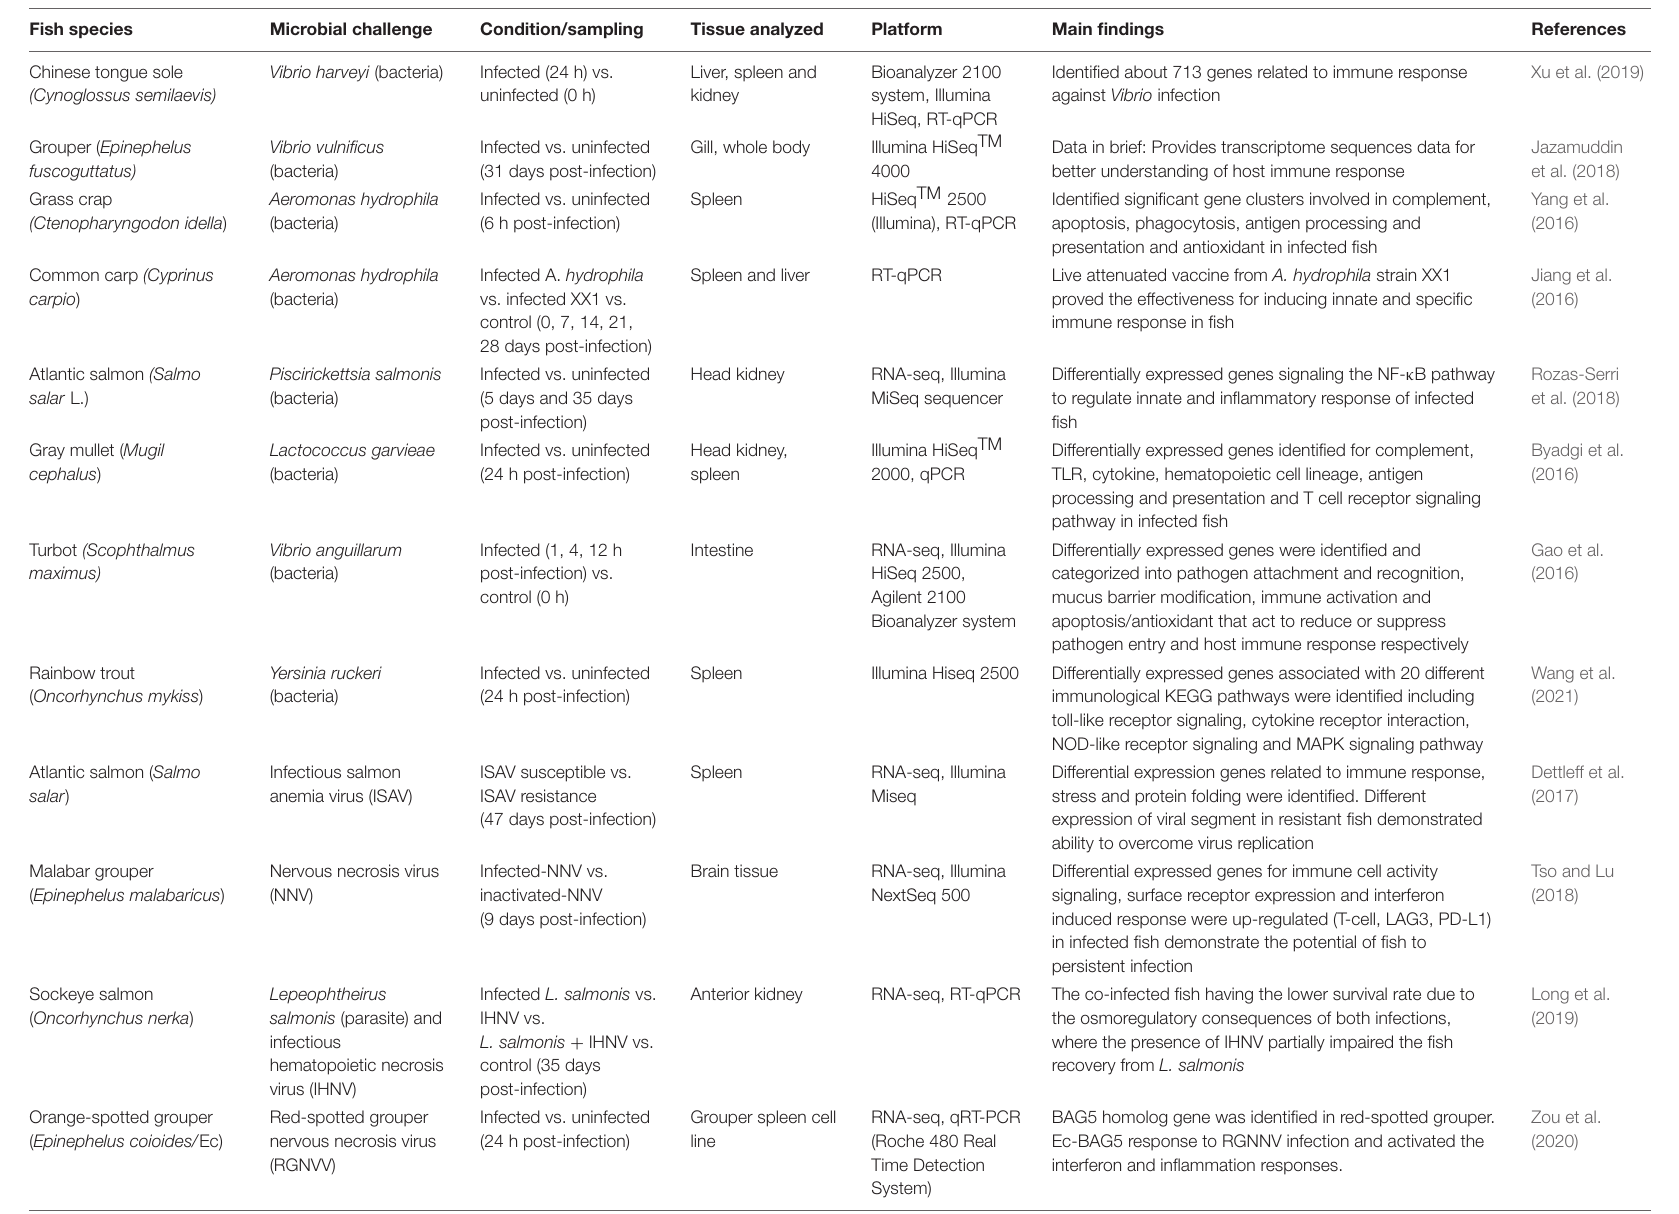
TABLE 2 | Summary of fish immune response study using transcriptomics